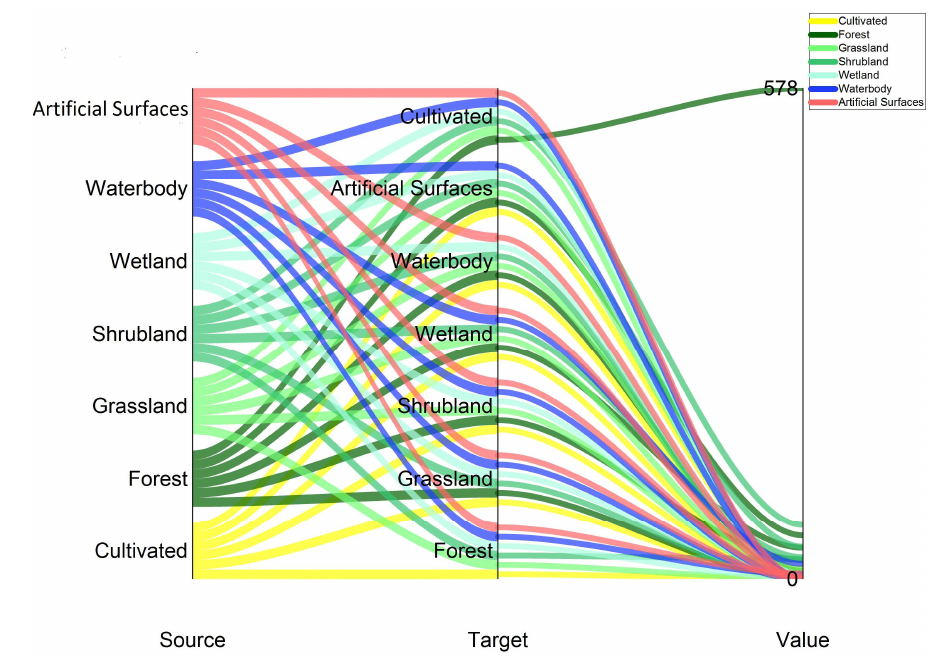
Figure 4. Flow chart of land-use and land cover change directions. Grazing land Table 6. Conversion matrix of land-use types in Benin tropical coastal zones from 2010 to 2020.